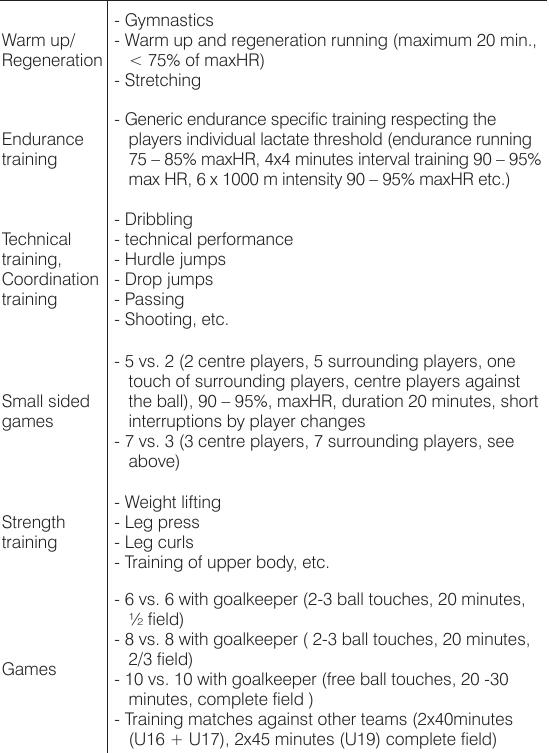
Table 1. Predetermined scheme in order to characterise different training aspects.